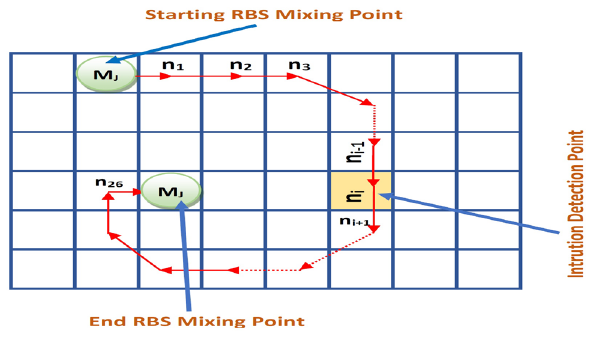
Fig. 18 Average RBS path length (P) of 32